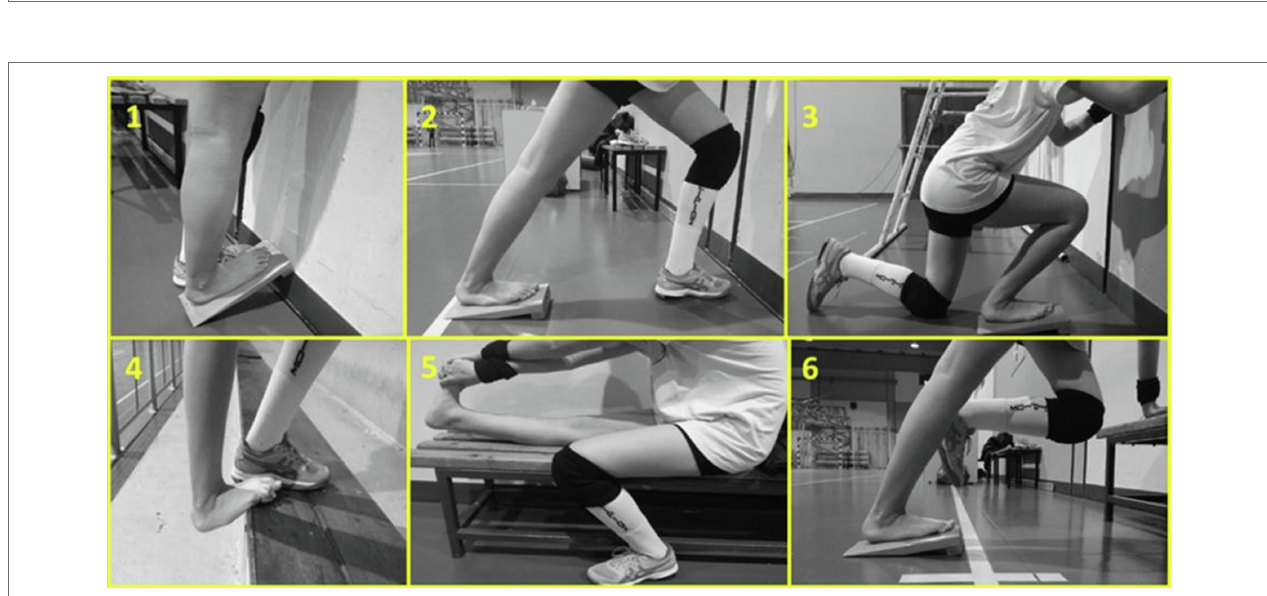
FIGURE 4 | Anatomical CSA of the stretched leg (STR) of the same participant’s gastrocnemius medialis (GM) and lateralis (GL; left : week-0, right :